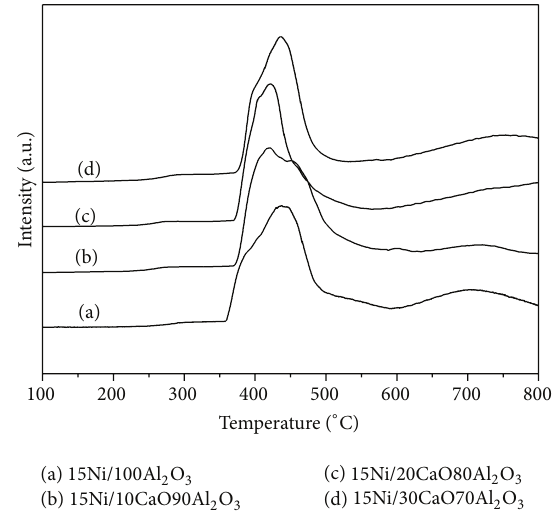
Figure 4: H 2 -TPR profiles of the catalysts with different CaO contents calcined at 500 ∘ C for 3 h.